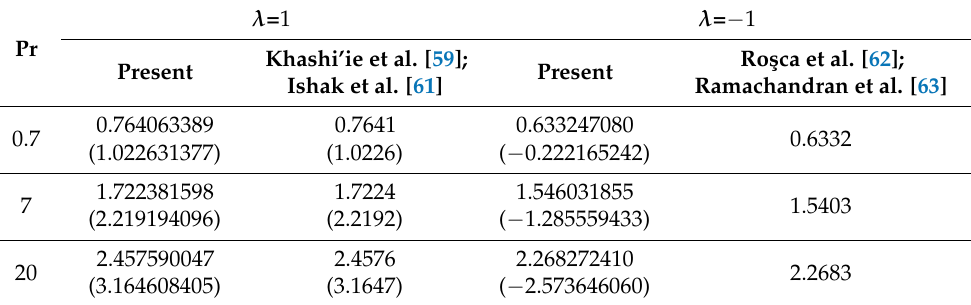
Table 4. Values of − θ (cid:48) ( 0 ) when N = Rd = Du = Sc = Sr = φ 1 = φ 2 = 0 and Bi → ∞ .